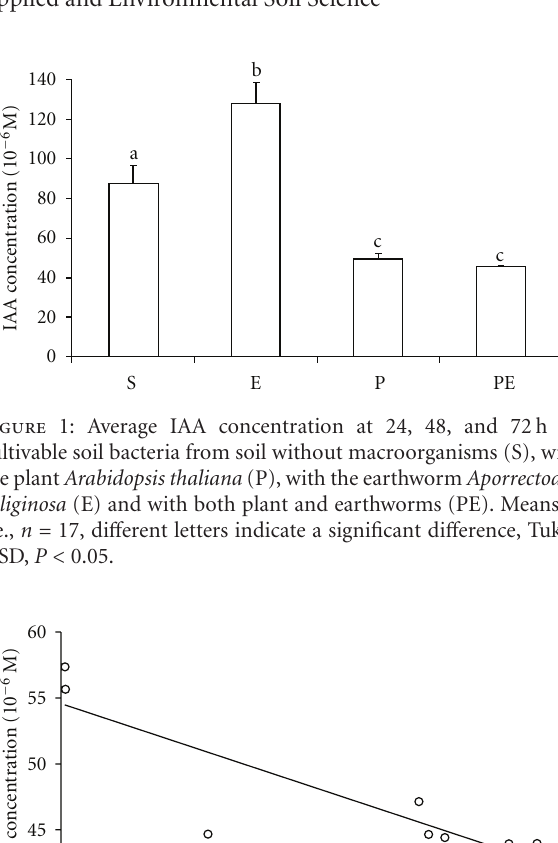
as well as the hormone-like e ff ects observed in compost made by earthworms